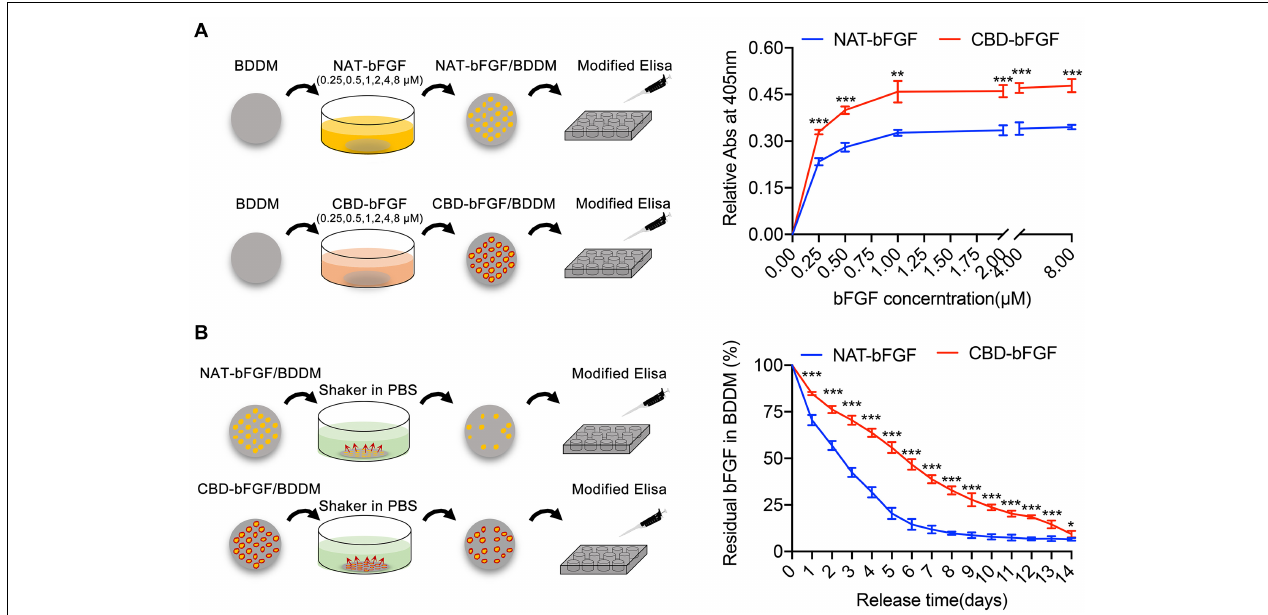
FIGURE 4 | (A) The binding curves of collagen-binding domain–basic fibroblast growth factor (CBD–bFGF) or natural (NAT)-bFGF on the collagens of book-shaped decellularized dermal matrix (BDDM). (B) The curves showed the residual proportions of CBD–bFGF or NAT-bFGF in CBD–bFGF/BDDM or NAT-bFGF/BDDM after rinsing in phosphate-buffered solution every day. Data ( n = 4) are shown as means ± standard deviation (* P < 0.05, ** P < 0.01, and *** P <